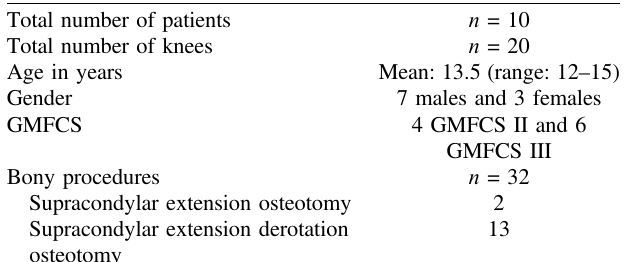
Table 1. Demographics and summary of the concomitant surgical procedures.